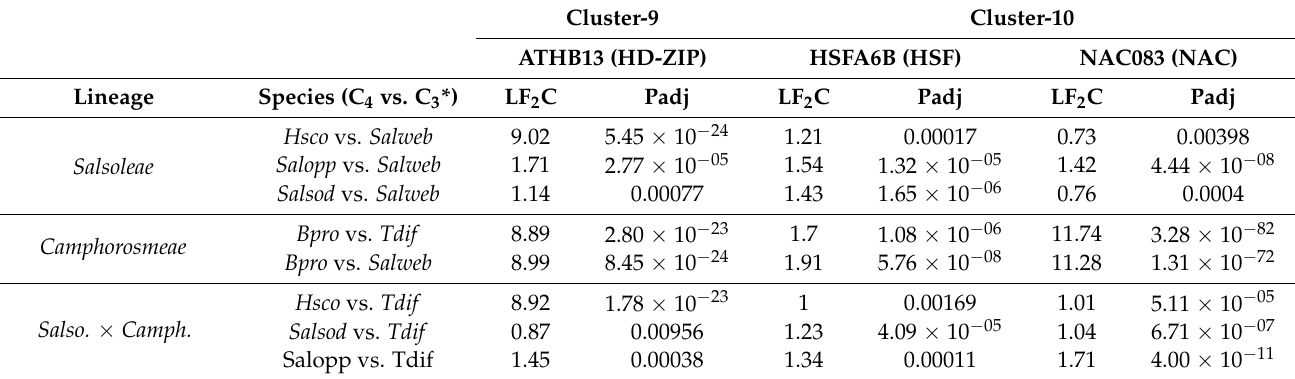
Table 4. Differentially expressed C 3 -related TFs in Amaranthaceae / Chenopodiaceae .